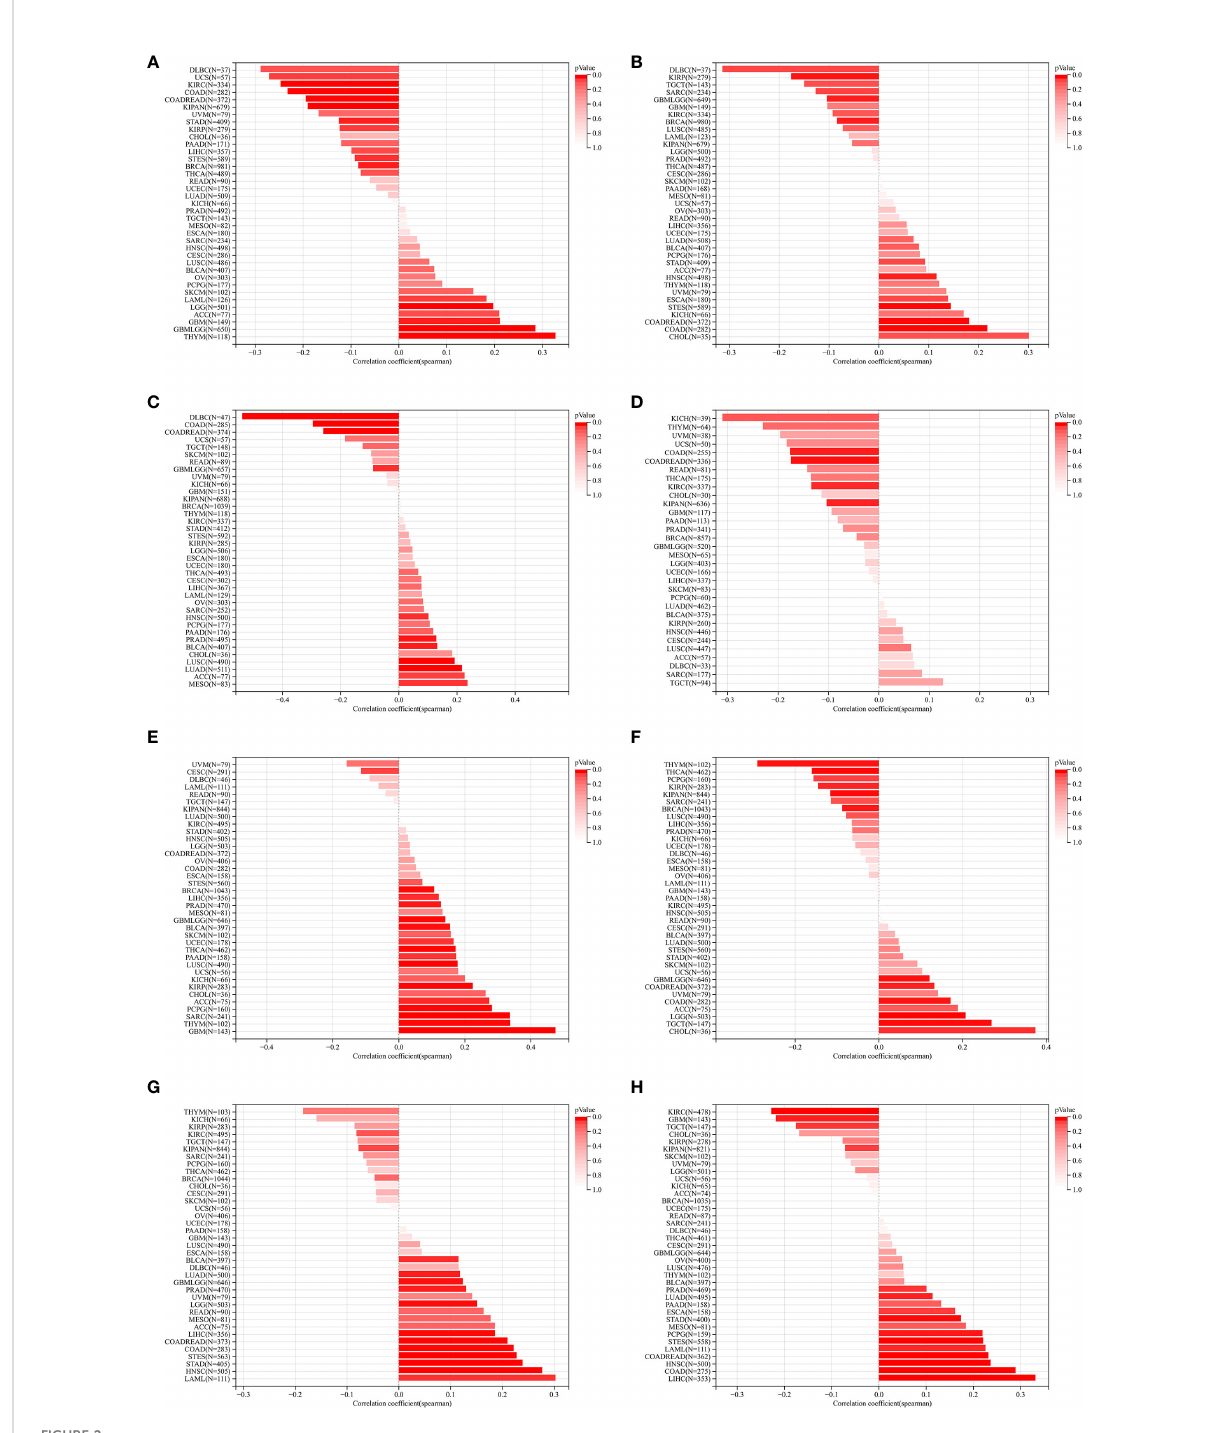
FIGURE 2 The pan-cancer Spearman analysis of tumor heterogeneity and ZNF419 expression. (A) the correlation between TMB and ZNF419 expression level; (B) the correlation between MATH and ZNF419 expression level; (C) the correlation between MSI and ZNF419 expression level; (D) the correlation between NEO and ZNF419 expression level; (E) the correlation between tumor purity and ZNF419 expression level; (F) the correlation between tumor ploidy and ZNF419 expression level; (G) the correlation between HRD and ZNF419 expression level; (H) the correlation between LOH and ZNF419 expression level. TMB, tumor mutation burden; MATH, mutant-allele tumor heterogeneity; MSI, microsatellite instability; NEO, neoantigen; HRD, homologous recombination de fi ciency; LOH, loss of